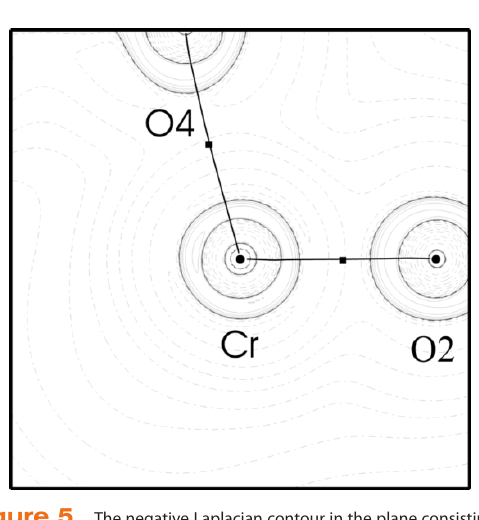
Figure 5. The negative Laplacian contour in the plane consisting of the central chromium atom and the oxygen atoms O2 and O4 for the compound 3 opt